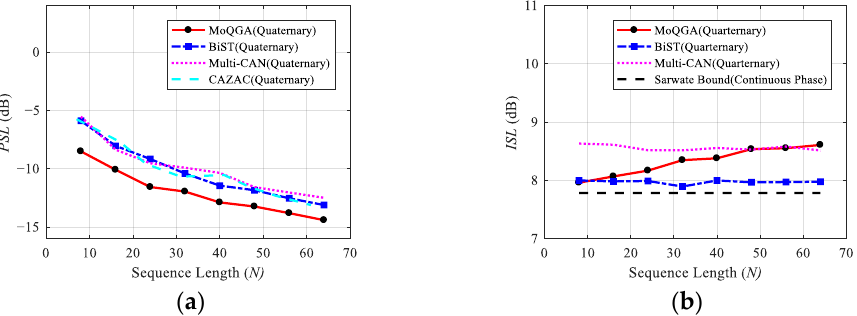
Figure 10. PSL and ISL values of MIMO radar quaternary phase code sequence set obtained by MoQGA and other methods under M = 3 and different code sequence length. ( a ) PSL ; ( b ) ISL .